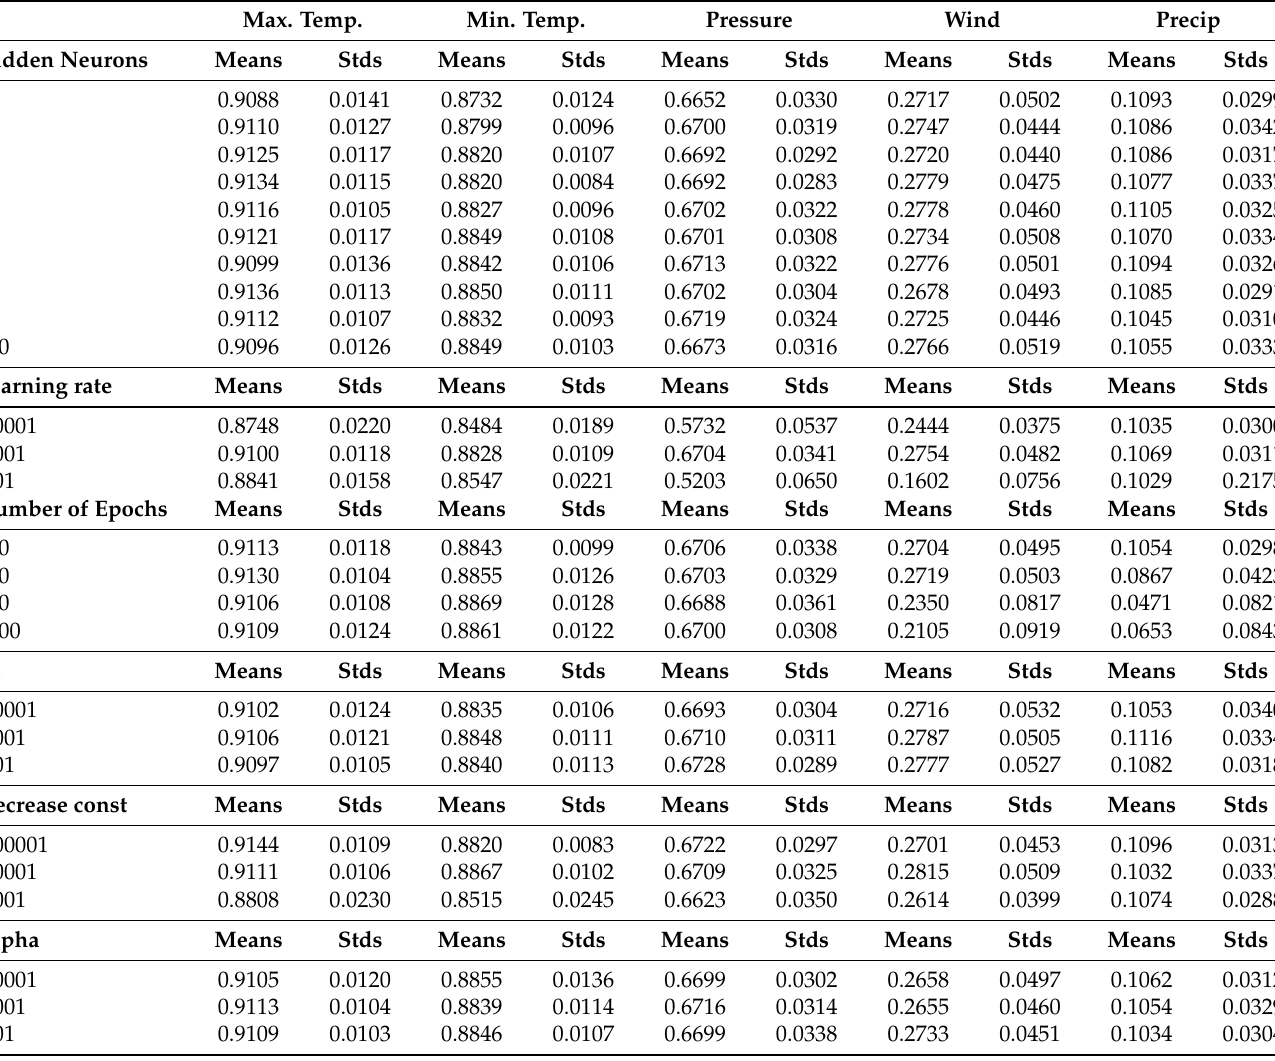
Table A7. The mean and standard deviation values of the MLP evaluation obtained with cross-validation for the predicted weather conditions.